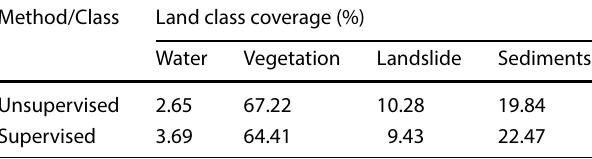
Table 2 Land class coverage for the two